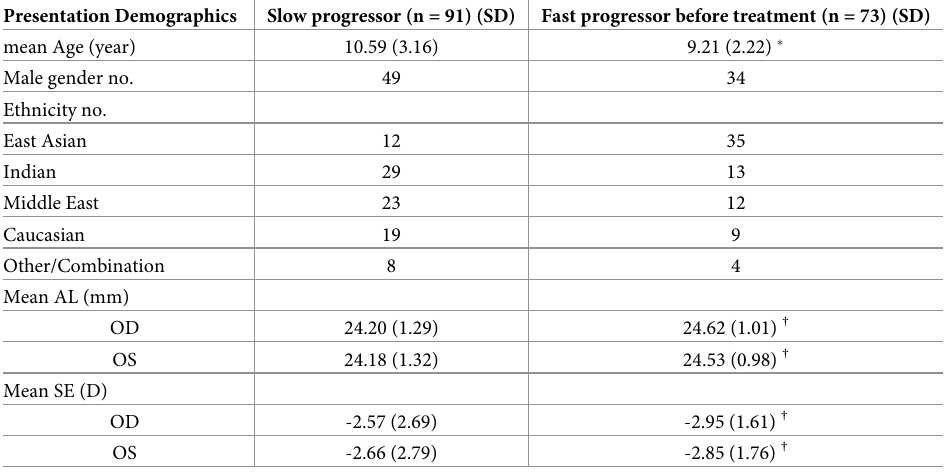
Table 1. Baseline demographics. Presentation Demographics Slow progressor (n = 91) (SD) Fast progressor before treatment (n = 73) (SD)